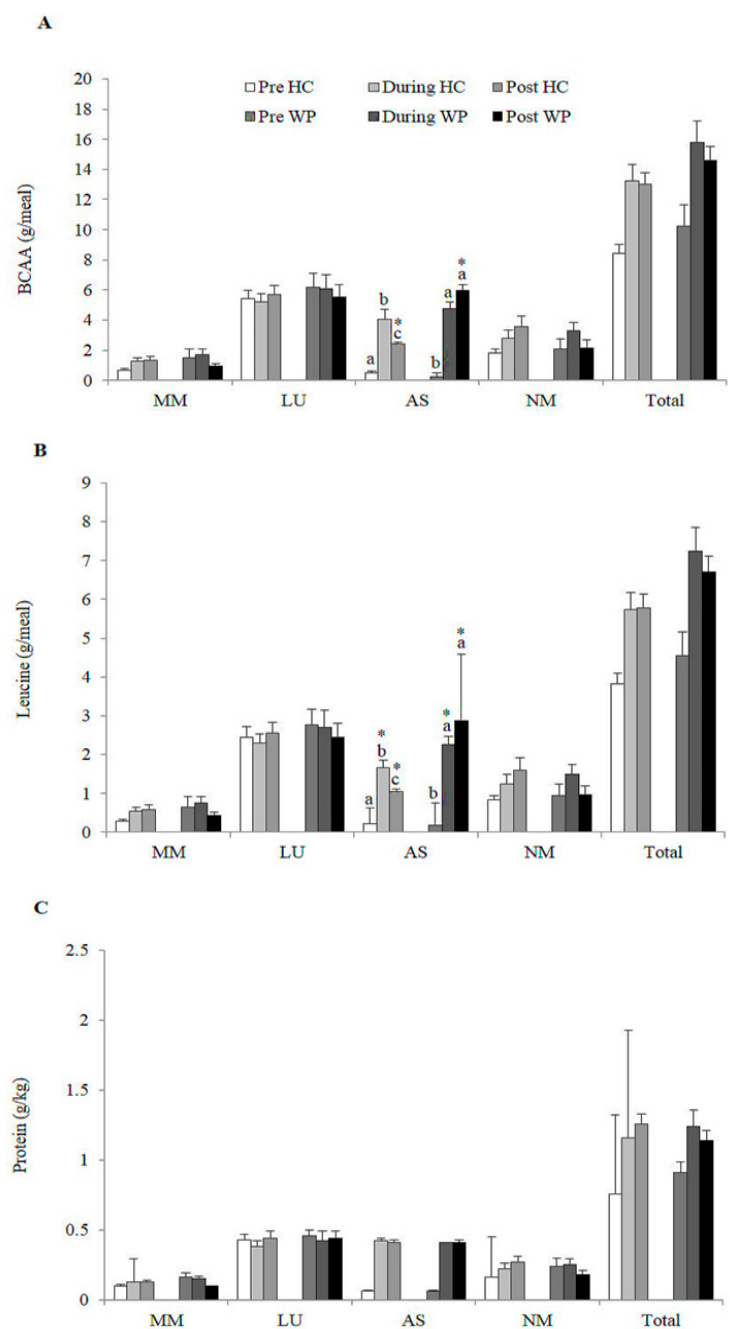
Figure 3. Distribution of total ( A ) Branched chain amino acid (BCAA) (g/meal); ( B ) Leucine (g/meal); ( C ) Protein (g/kg) consumption between meals performed by the participants of each group; HC: Hydrolysed collagen; WP: Whey protein; Afternoon snack; LU: Lunch; AS: Afternoon snack; MM: Morning meal; NM: Evening meal. Equal lowercase letters indicate means that do not di ff er statistically from one another by the Sidak test at Table 5. level of significance in the comparison between groups within each time. * indicate means that do not di ff er statistically from each other by the Sidak test at the 5% level of significance in the comparison between times within each